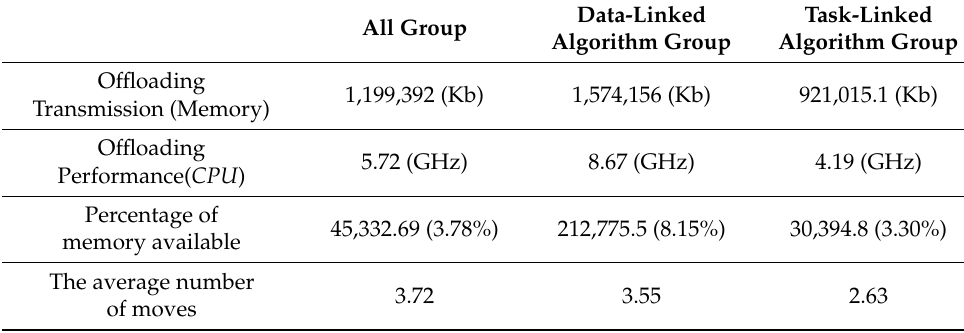
Table 4. Data & Task algorithm performance evaluation.